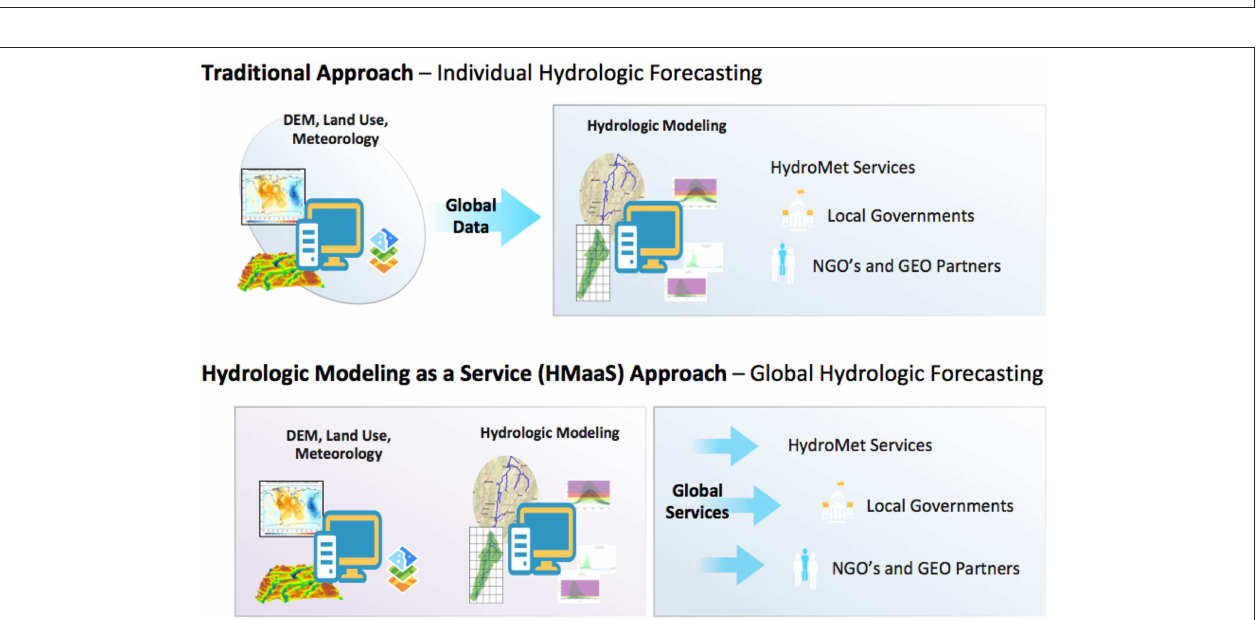
FIGURE 2 | Traditional vs. HMaaS